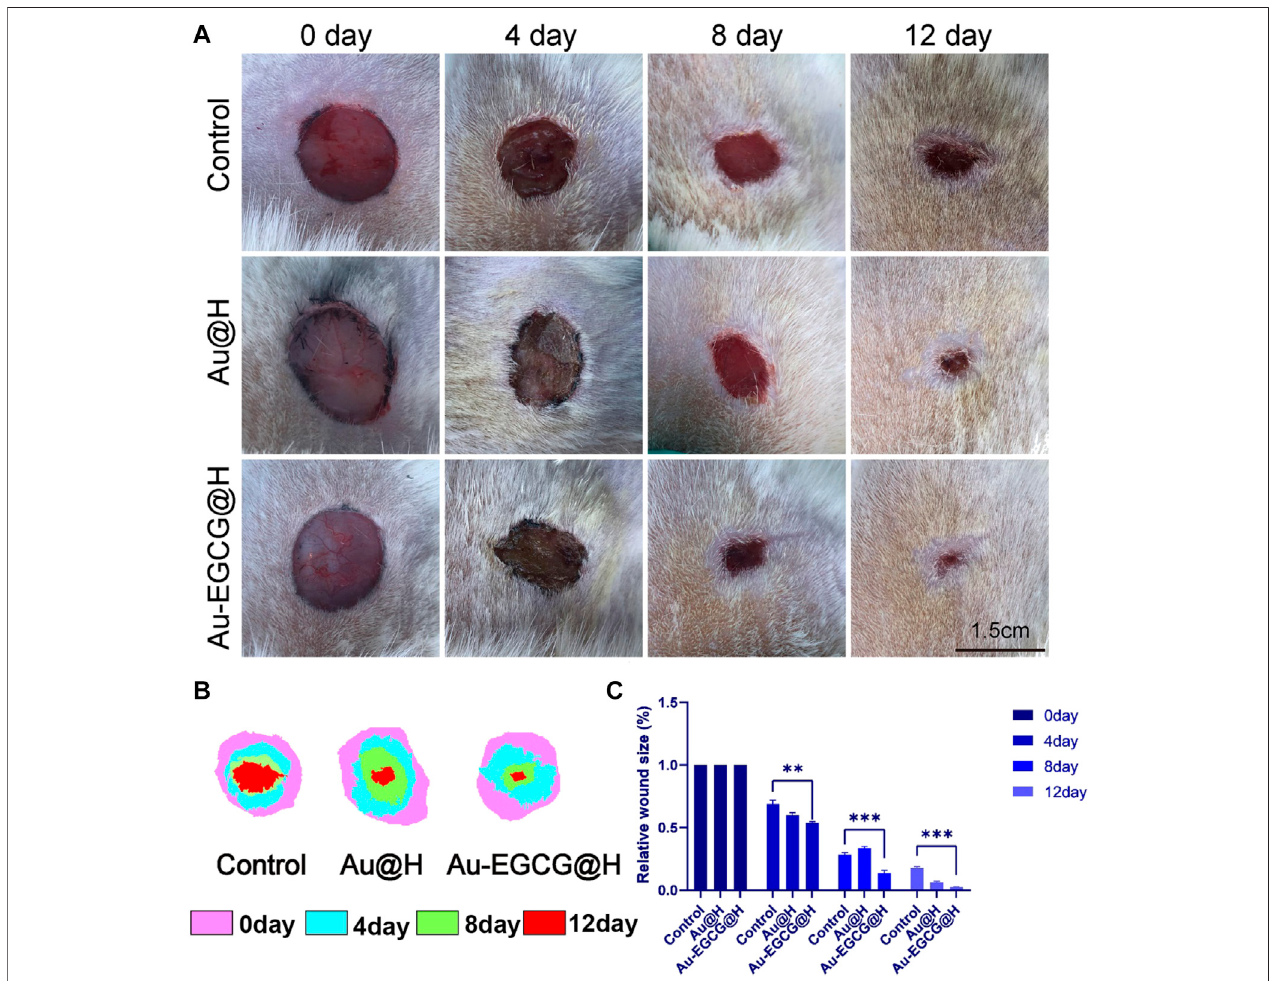
FIGURE 6 | Gross changes of the wound site. (A) The image of the diabetic skin wound after operation, bar (cid:2) 1.5 cm. (B) The wound-bed closure traces within 12 days of each treatment. (C) Wound closure rate analysis. * p < 0.05, ** p < 0.01, *** p < 0.001.